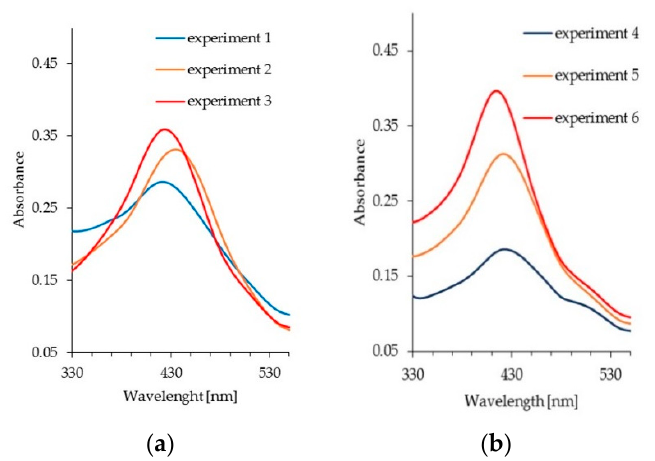
Figure 5. UV-Vis spectra of silver nanoparticles stabilized with gemini surfactants ( a ) 16-6-16; ( b ) 16-O-16 at different nAg/nGemini values. O-16 at different nAg/nGemini